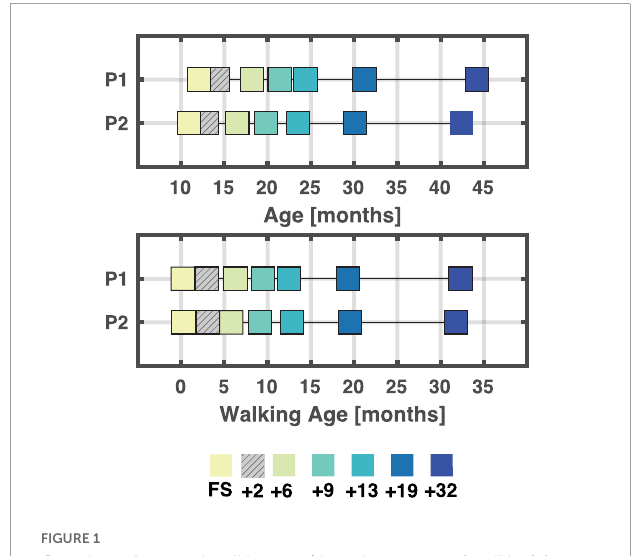
FIGURE1 Overview of age and walking age (time since onset of walking) for each session/child. A total of seven sessions were recorded for each child. At the end, six sessions were analyzed for each child, and these were matched based on walking age (bottom plot) in months. A few weeks separate the different sessions between P1 and P2. +2 is hatched as not analysed due to poor data quality. FS: First steps, +2, +6, +9, +13, +19, +32 refers to the number of months since first steps, i.e., time since onset of independent walking.